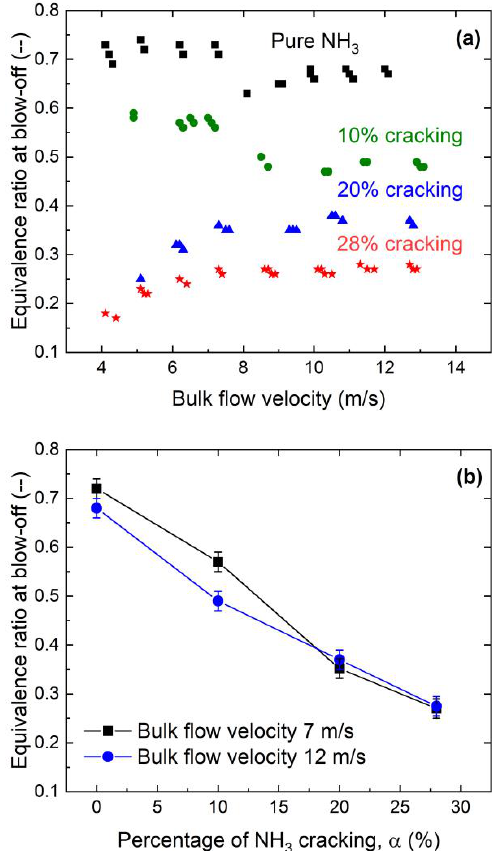
Figure 5. ( a ) Equivalence ratio at blow-off as a function of the bulk flow velocity for pure ammonia flames (black squares), 10% cracking (green circles), 20% cracking (blue triangles), and 28% cracking (red stars). Each condition was repeated four times. ( b ) Equivalence ratio at blow-off as a function of ammonia cracking for two bulk flow velocities, 7 m/s and 12 m/s. Error bars correspond to uncertainties in the measurements.